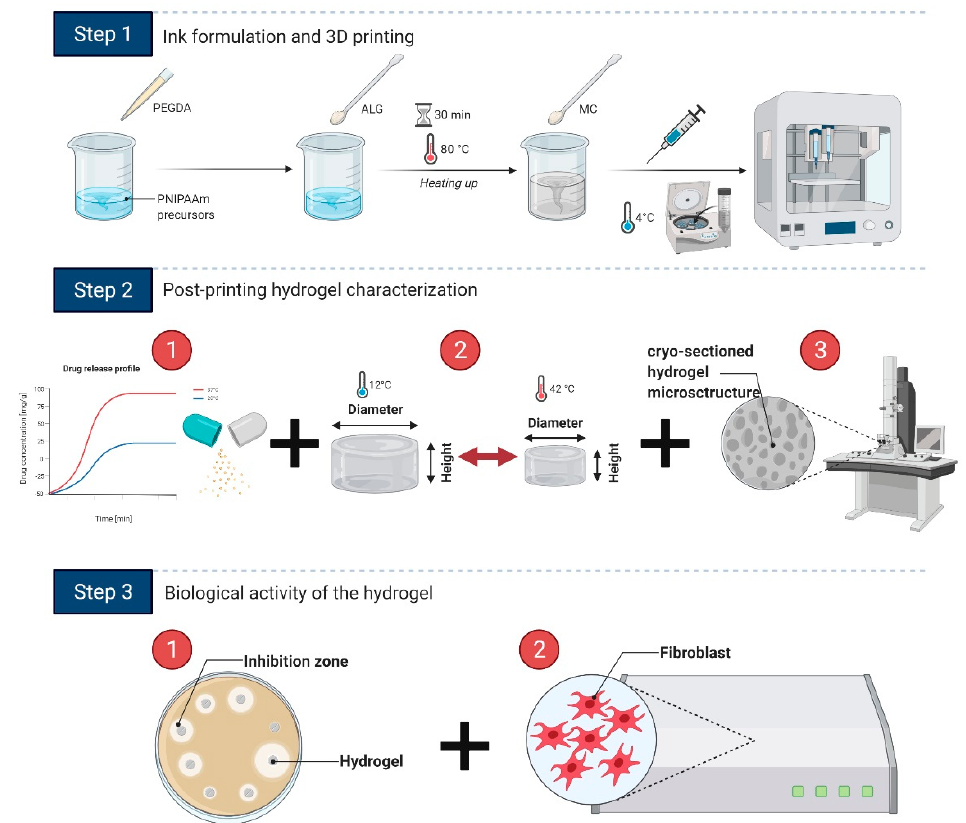
Figure 1. Summary of the procedure: Step 1 demonstrates all steps of the ink formulation and 3D printing including the addition of hydrogel precursors and pre-printing stages such as bubble removal and pouring the ink into a printing syringe; Step 2 presents the main characterization stages that include ( 1 ) OCT release profile determination, ( 2 ) swelling tests, and ( 3 ) SEM observations of the hydrogel cross-sectioned structure; in Step 3, the hydrogel is characterized for its antimicrobial activity and biocompatibility. Created using Biorender.com.